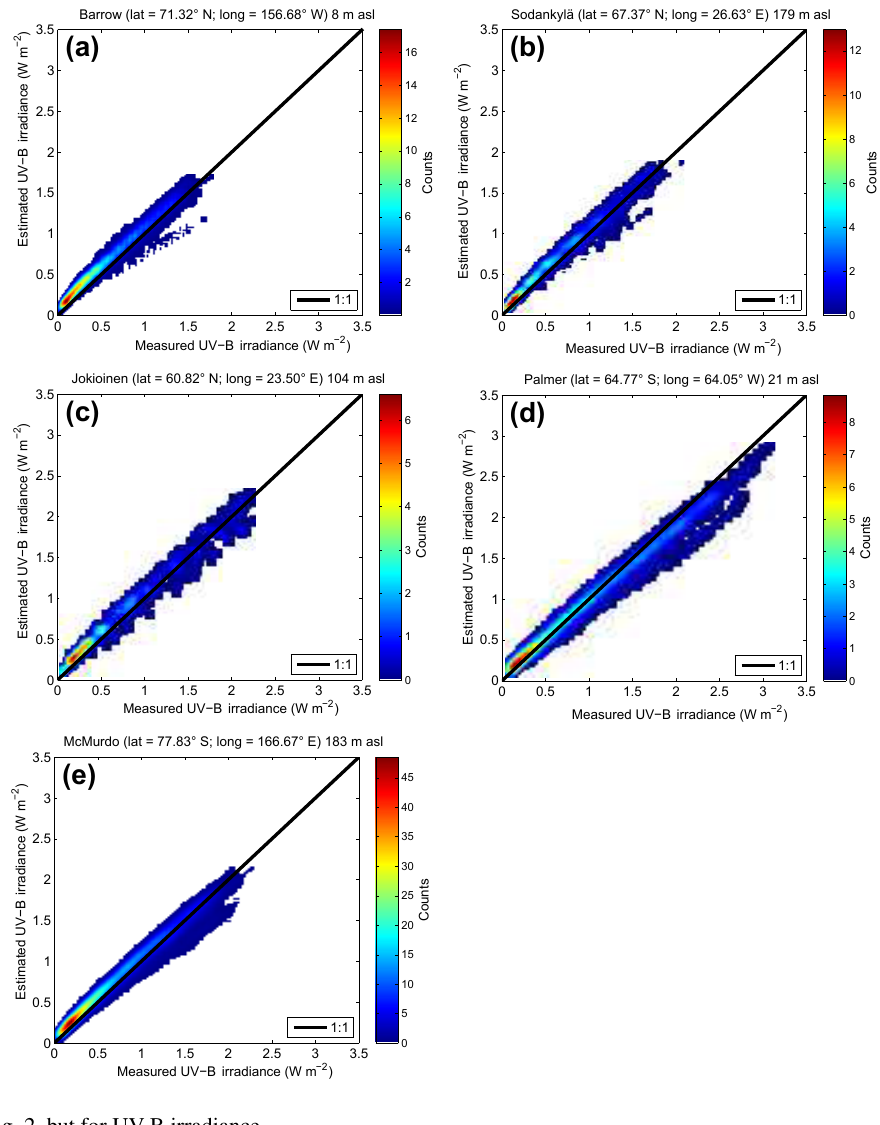
Figure 4. Same as Fig. 2, but for UV-B